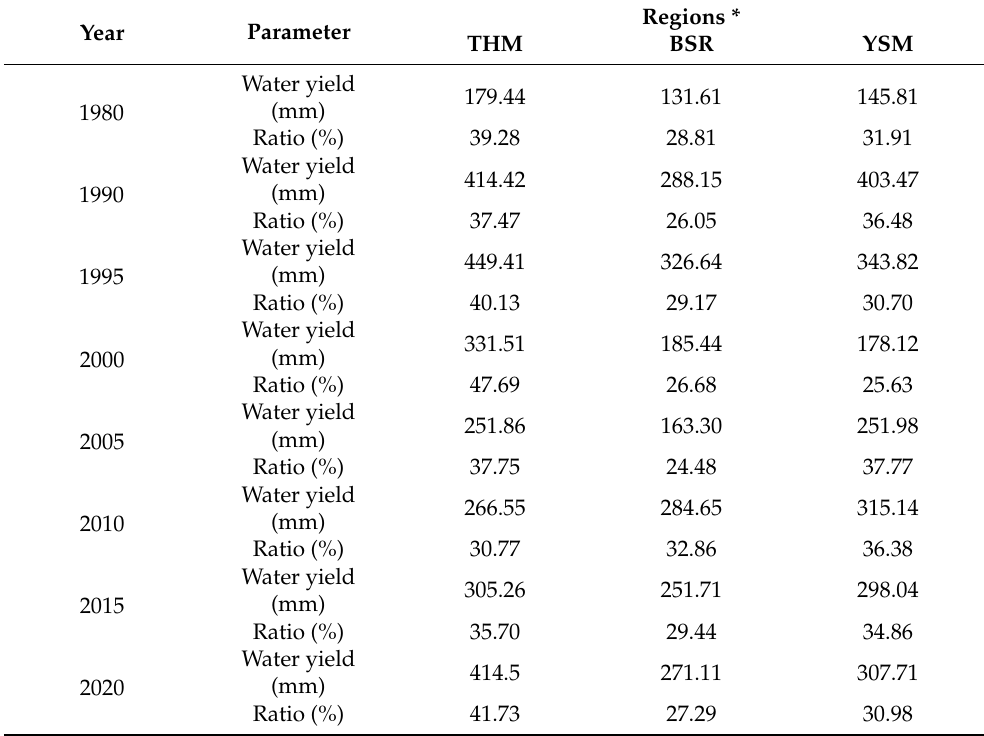
Table 3. Water yield (in mm) and ratio of water yield in different regions to the total water yield in the eight years during